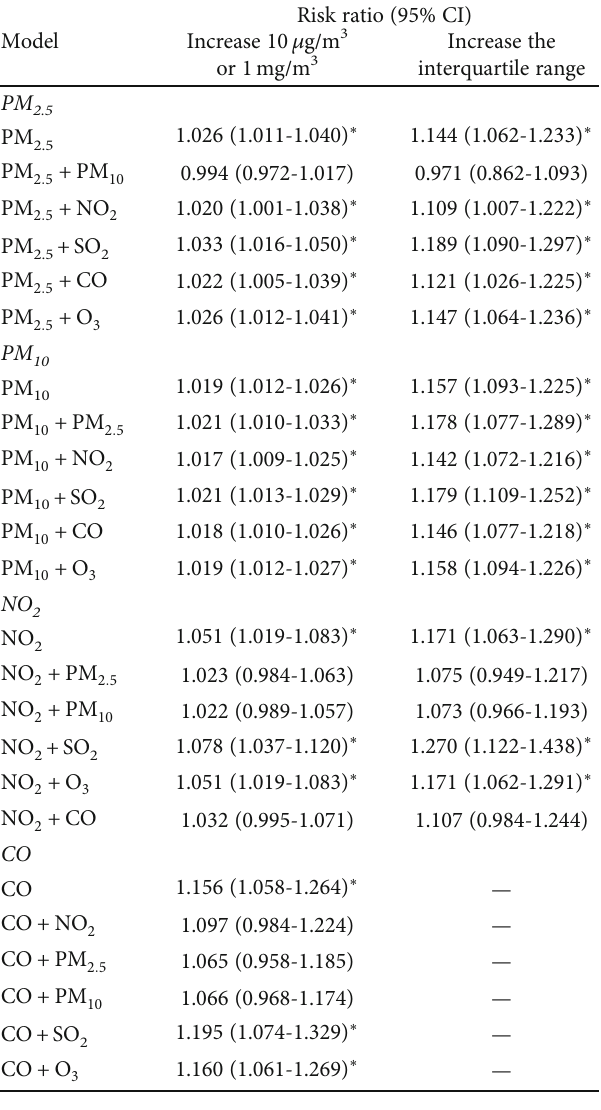
Table 5: Fitting results of single and double air pollutant